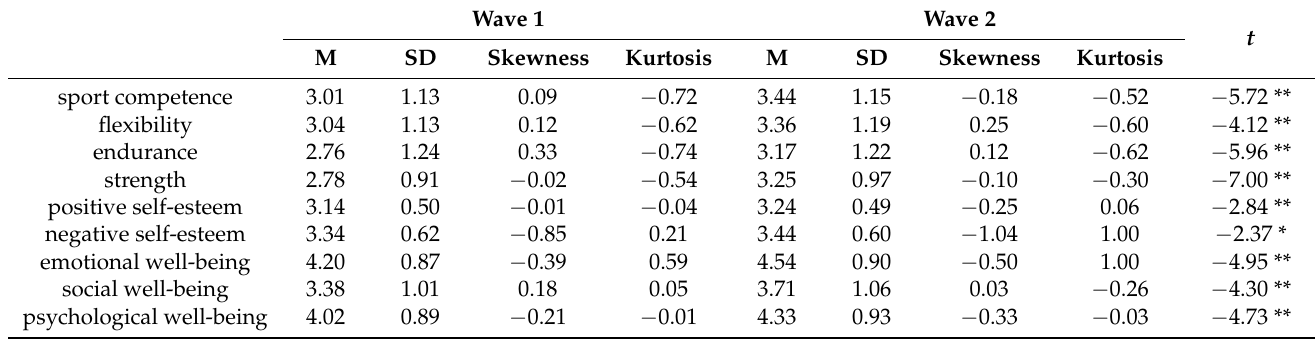
Table 1. Descriptive statistics and paired sample t -test.